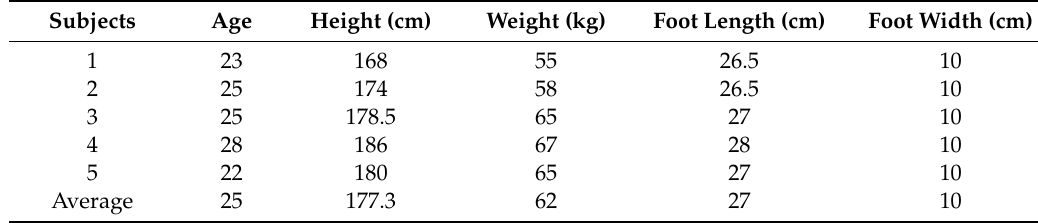
Table 1. The subjects’ physiological